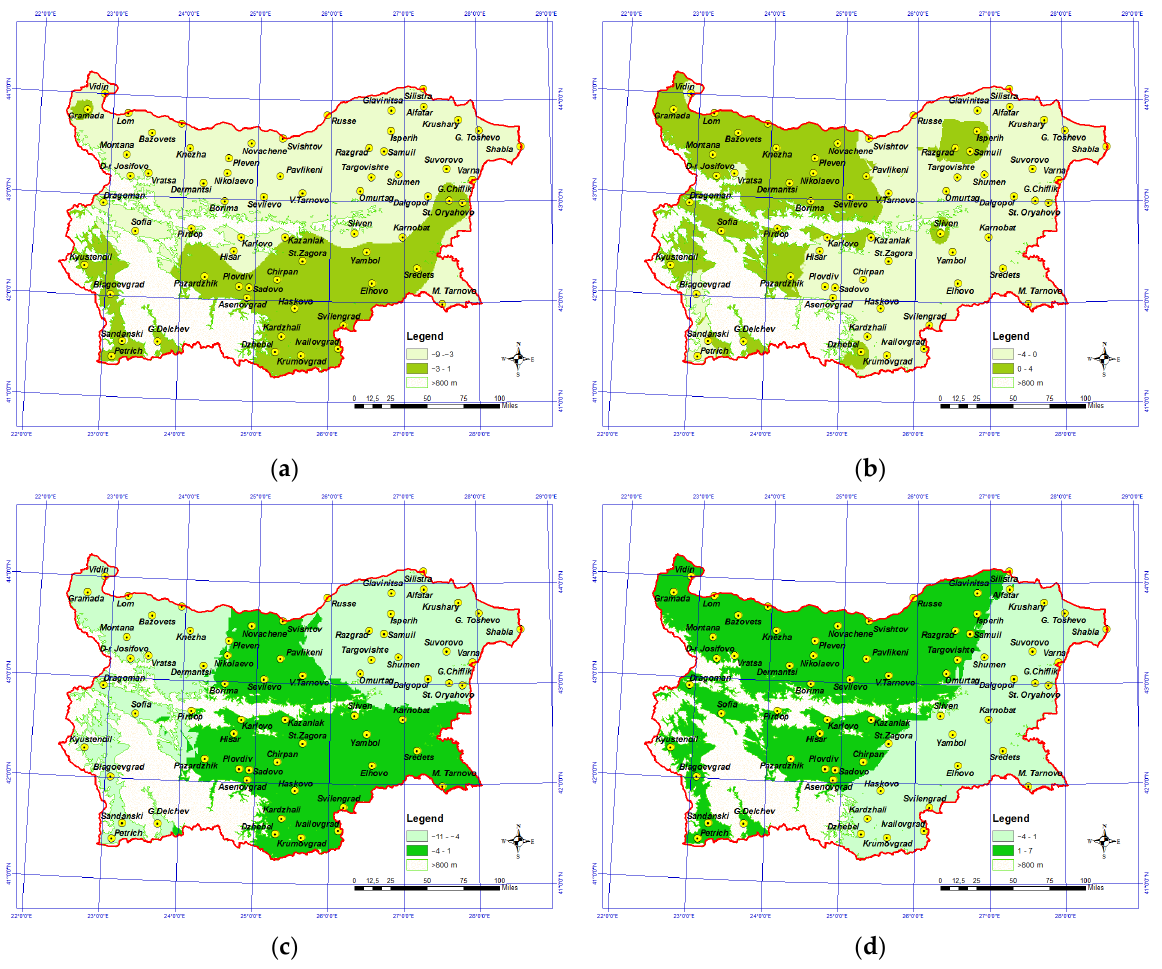
Figure 5. Deviations in the dates of transition the air temperature above and below 5 and 10 °C during the spring and autumn: ( a ) spring 5 °C; ( b ) autumn 5 °C; ( c ) spring 10 °C; and ( d ) autumn 10 during the spring and autumn: ( a ) spring 5 ◦ C; ( b ) autumn 5 ◦ C; ( c ) spring 10 ◦ C; and ( d ) autumn °C. 10 ◦